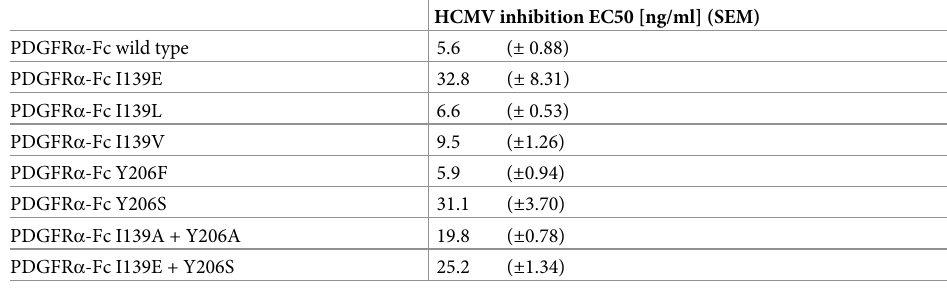
Table 1. Overview of HCMV inhibition by PDGFR α -Fc I139 and Y206